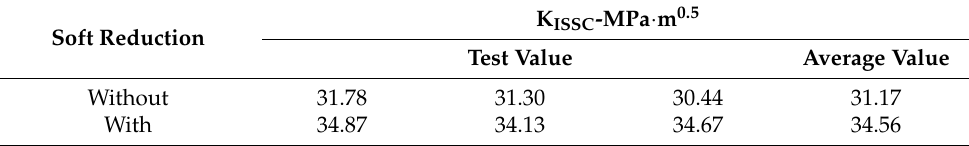
Table 2. K ISSC of oil pipes in DCB test.